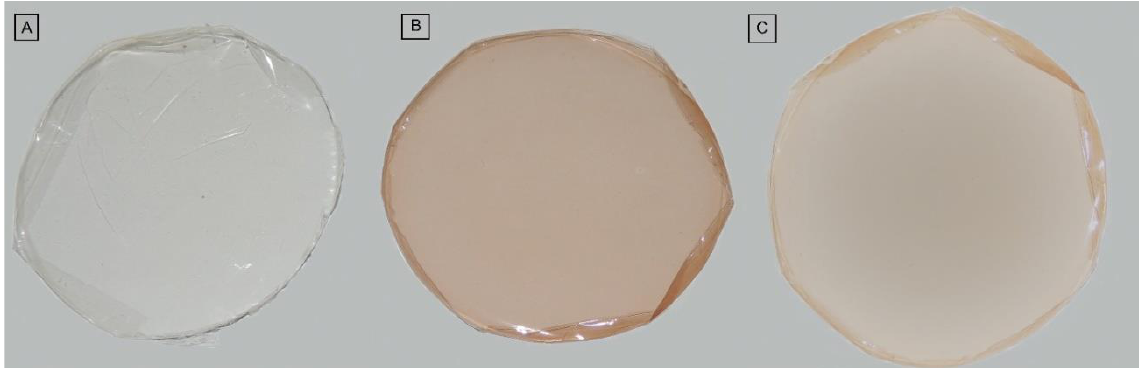
Figure 4. Photographs of gelatin biomembrane — GEL ( A ), gelatin biomembrane containing S. adstringens extract — GELSA ( B ) and gelatin biomembrane containing A. cochliacarpa extract — GELAC ( C ).